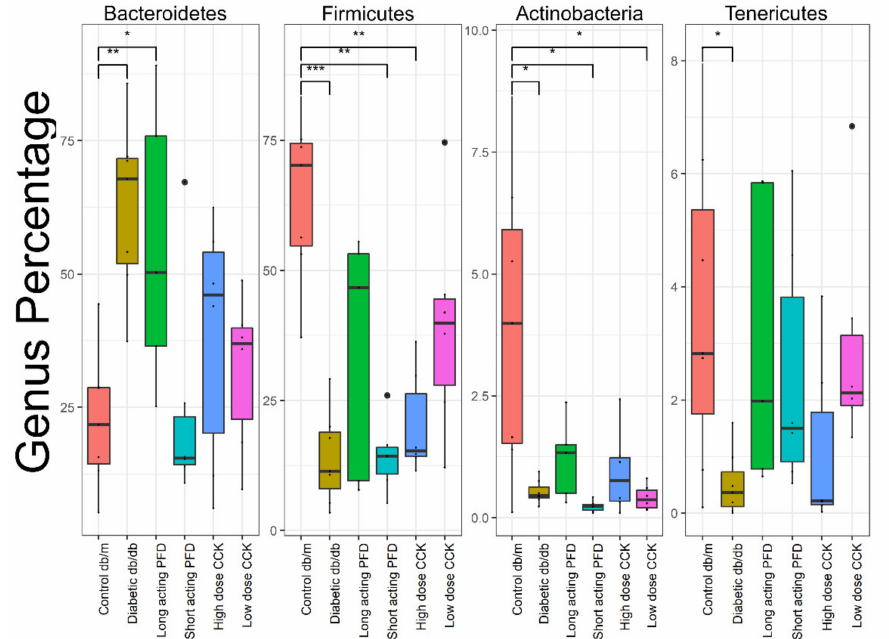
Figure 3. Phylum level comparison between control db / m, db / db, and four treatment groups. Significance levels between two groups is indicated by stars (* 0.01 to 0.05, ** 0.001 to 0.01, *** 0.0001 to 0.001) and no comparison / stars mean no statistical significance was found between groups.